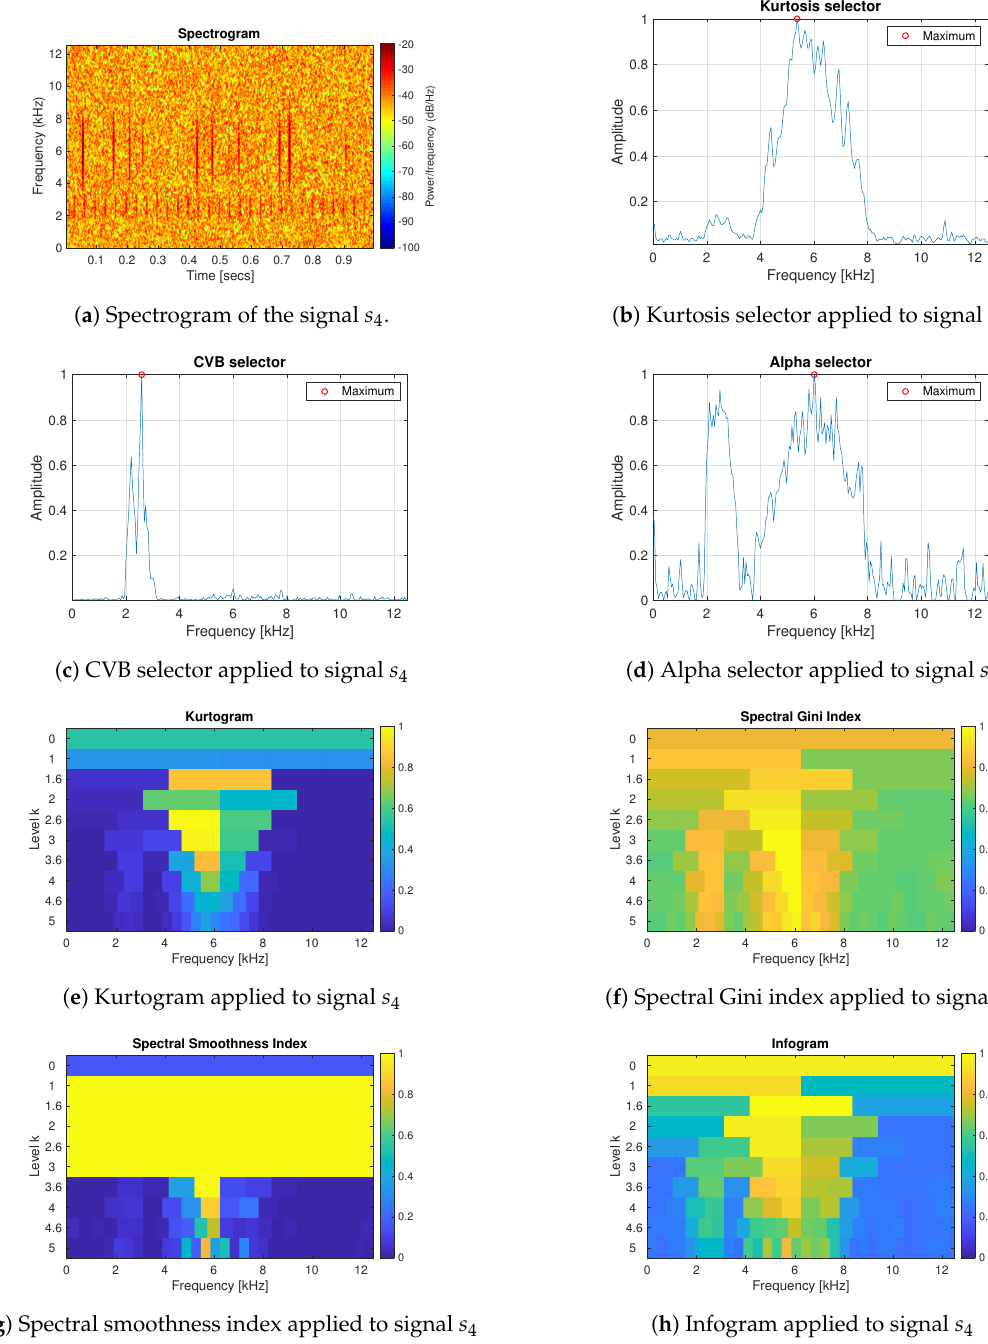
Figure A4. Normalized results of the informative frequency band selection for 7 different methods for the signal s 4